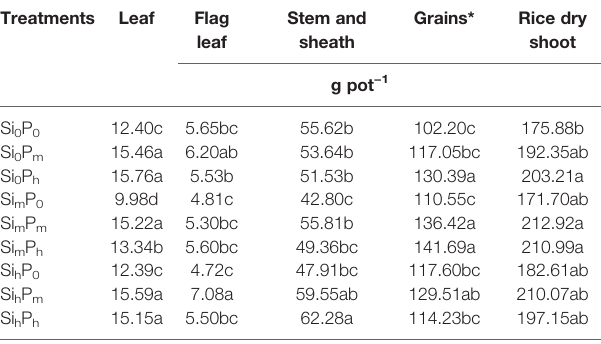
Treatments Leaf Flag